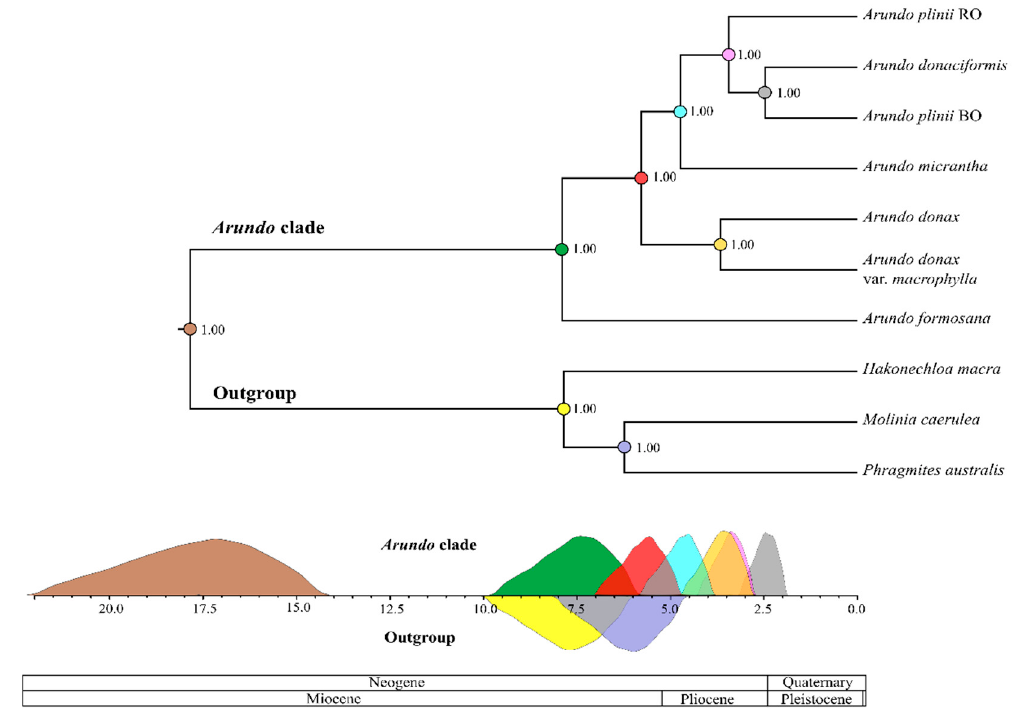
Figure 4. Chronogram of the Arundo genus based on the set of 144 nuclear genes. Numbers close to nodes indicate posterior support. The scale under the tree is in million years and the 95% CIs are drawn in the color of the node they correspond to in the chronogram. The 95% CI for the Arundo ingroup is above the scale and under the scale for outgroups.